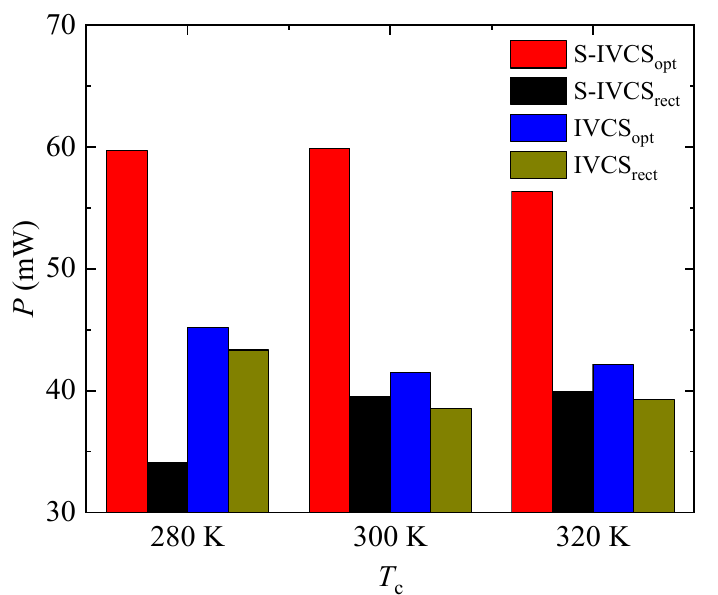
Figure 12. Comparison of the output power for various designs at T c = 280 K, 300 K, and 320 K.